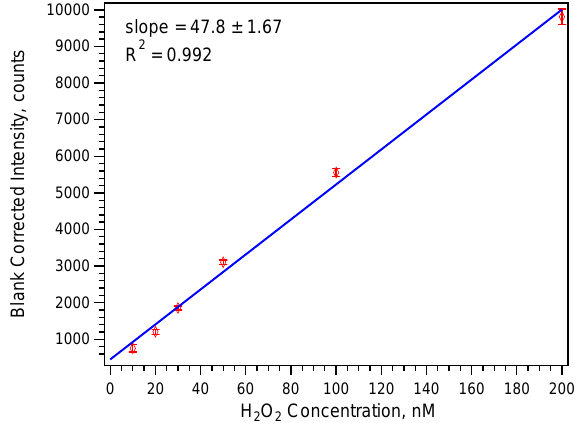
Fig. 6. Calibration of online ROS assay using DCFH with known concentrations of H 2 O 2 . Error bars represent the standard deviation of multiple measurements ( n = 5).